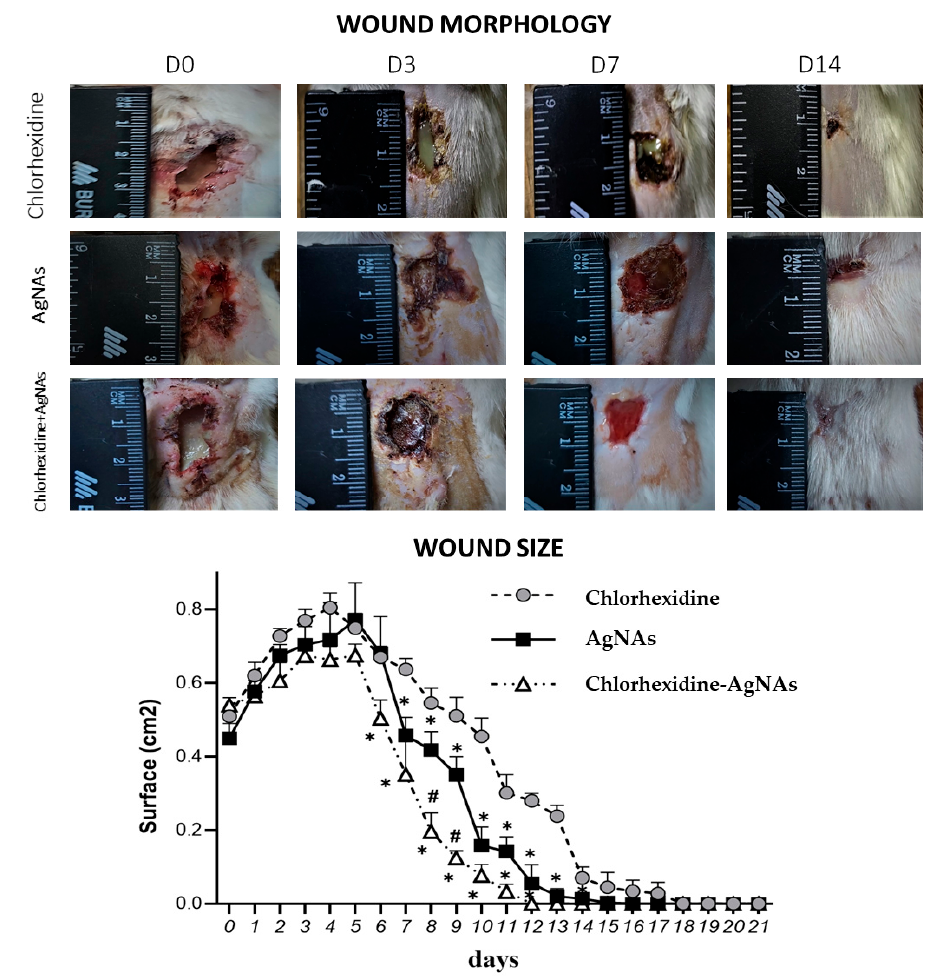
Figure 4. Upper section—photographs of the wound at different time-points after the application of the treatments (chlorhexidine, AgNAs, and combined chlorhexidine–AgNAs). On day 21, all the experimental groups experienced a complete wound epithelization. Lower section—wound size measurements after the treatment by chlorhexidine, AgNAs, and combined chlorhexidine–AgNAs. *—significant difference from the chlorhexidine group ( p ≤ 0.05); #—significant difference between AgNAs and chlorhexidine–AgNAs groups ( p ≤ 0.05).